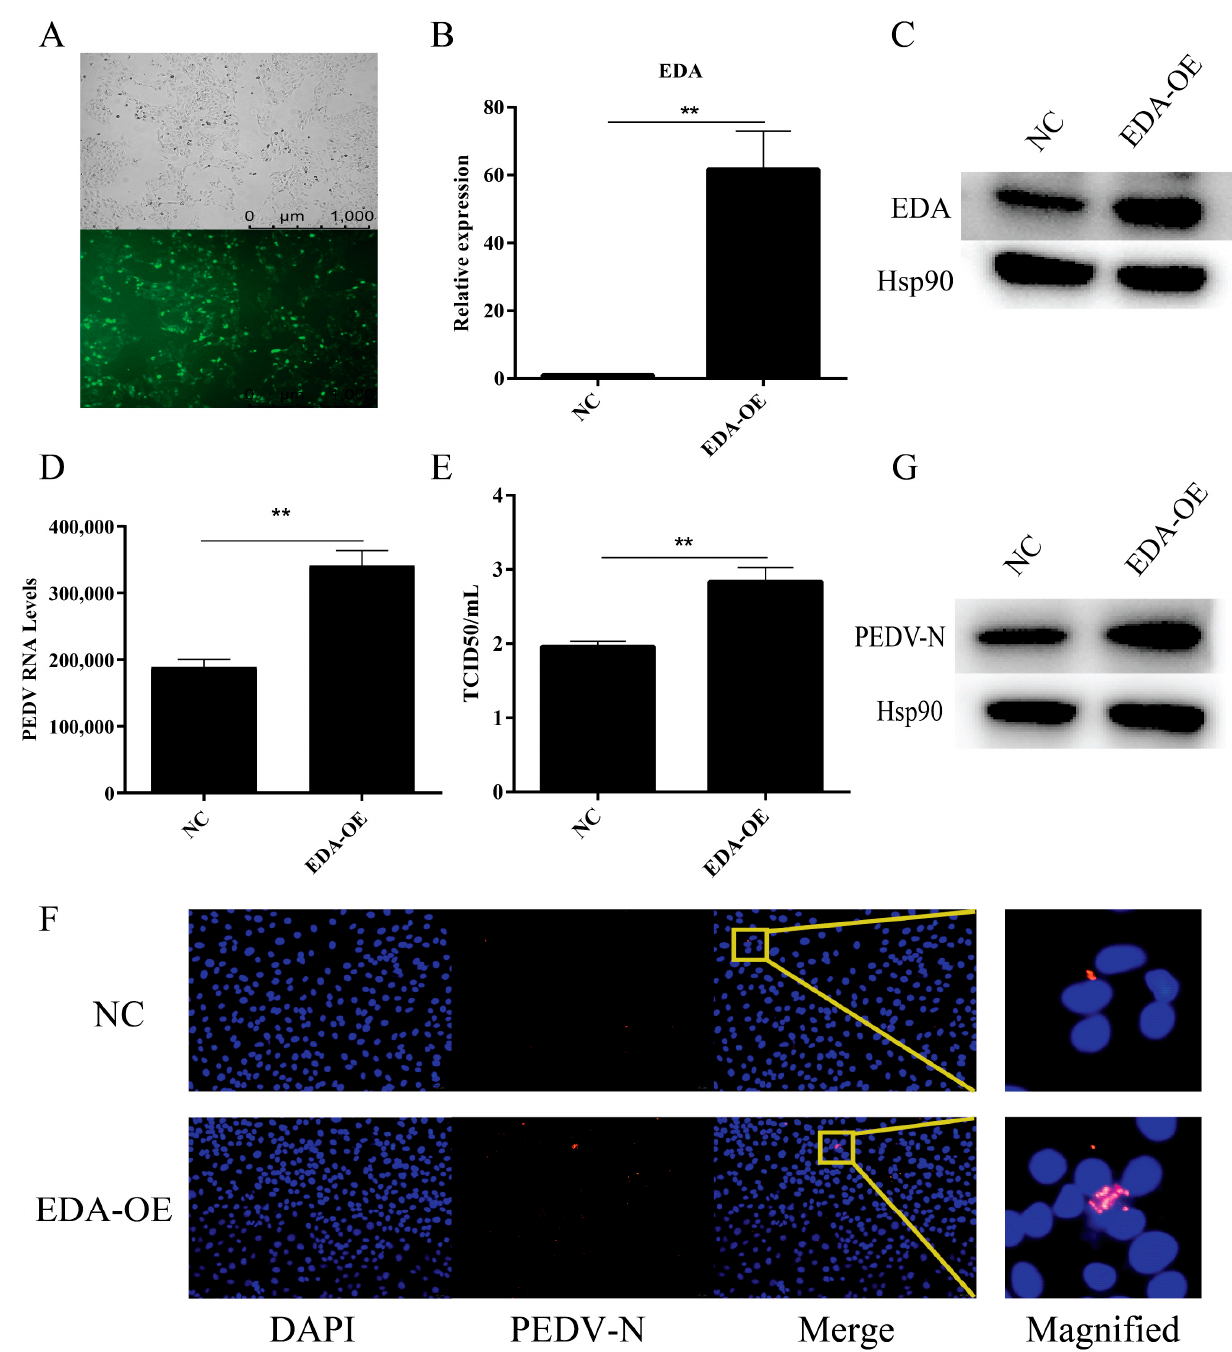
Figure 3. Effect of the EDA gene on PEDV viral replication. ( A ) The transfection efficiency of the EDA overexpression plasmid; the upper panel shows the corresponding cells in the absence of fluorescence exposure, showing the overall density of the cells. ( B ) Expression levels of EDA gene in different treatment groups. ( C ) Expression levels of EDA protein in the different treatment groups. ( D ) Differential analysis of PEDV copy number in cells infected with PEDV with different treatments. ( E ) Analysis of TCID50 results of cells infected with different treatment groups by PEDV. ( F ) Effects of different treatments on PEDV replication. ( G ) Expression levels of EDA protein in different treatment groups. The ** denotes a significant difference with p <